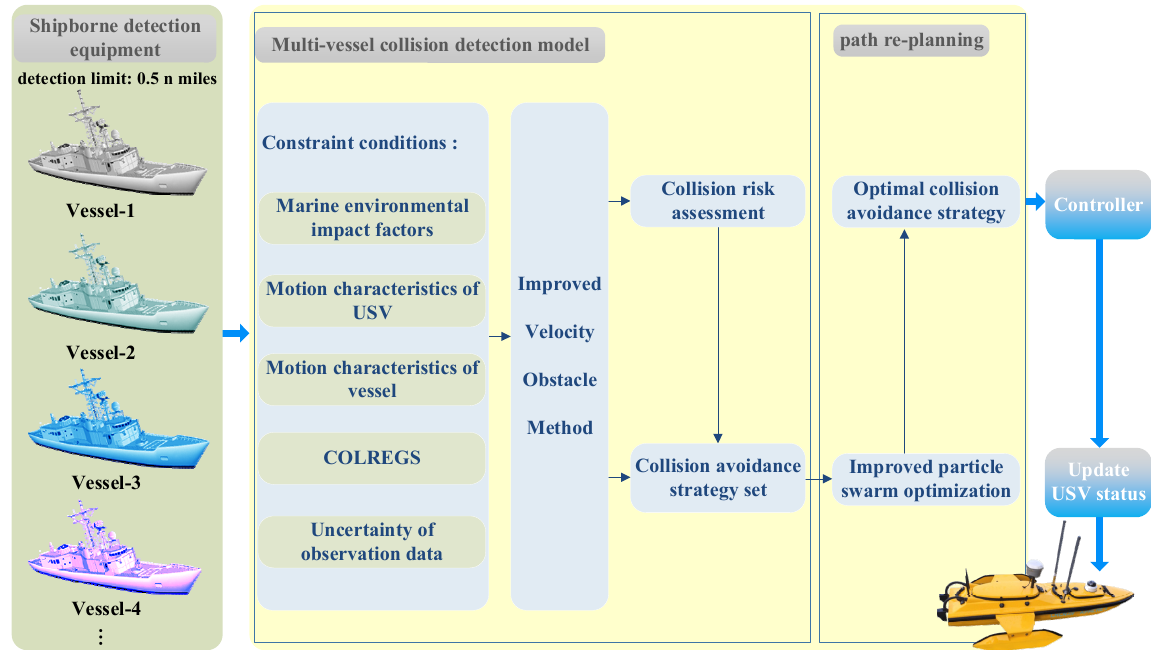
Figure 1. USV autonomous obstacle avoidance process in the scenario of multi-vessel encounters.